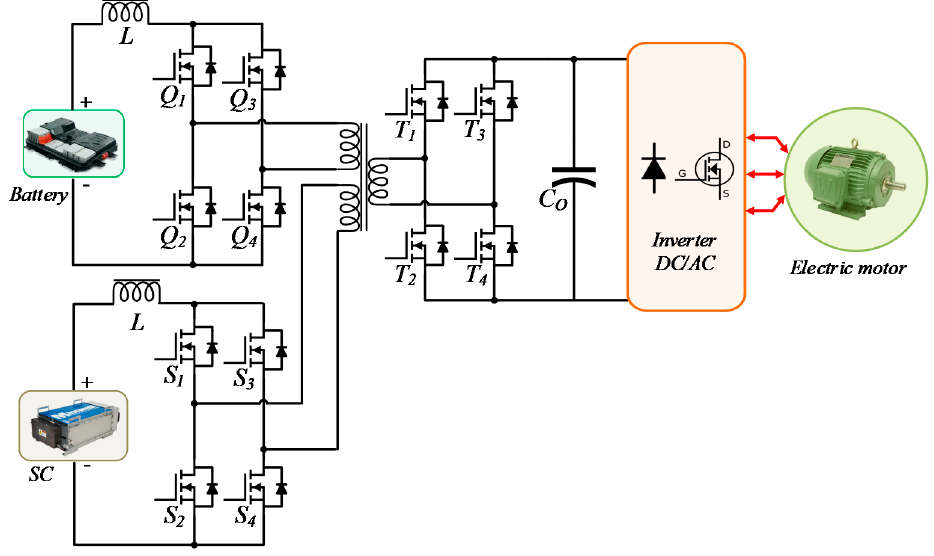
F igure 12. Multiport DC-DC Converter. Figure 12. Multiport DC-DC